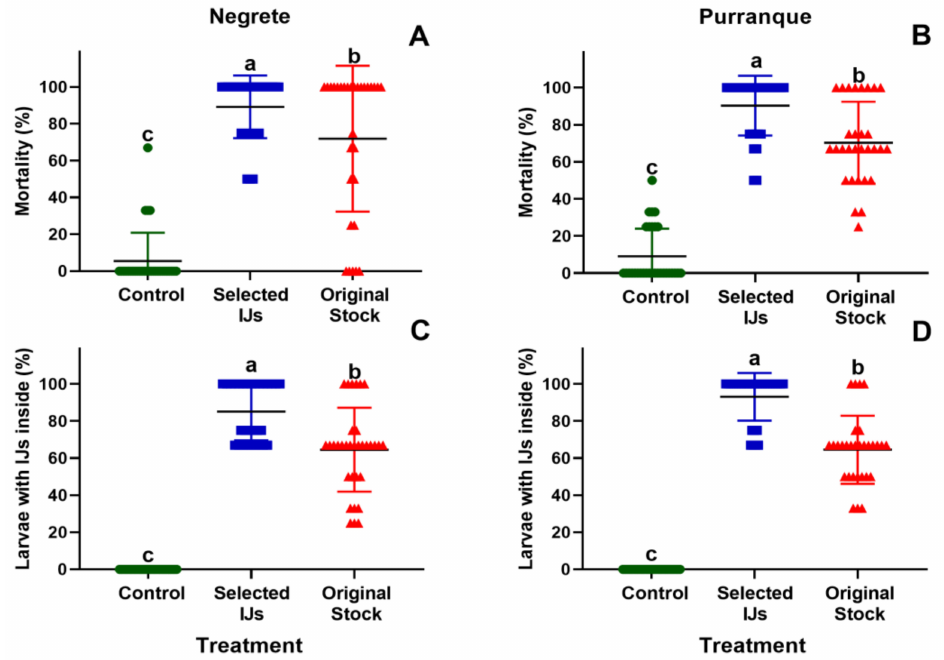
Figure 6. Efficacy (mean ± SEM) of the selected S. australe IJs (blue), original stock S. australe IJ (red), and control without nematode (green) in blueberry and sarsaparilla orchards, measured as a percentage of larval mortality ( A , B ); the percentage of larvae with a confirmed infection by EPN ( C , D ). Different letters indicate significant differences according to the Tukey HSD test ( p ≤ 0.05). With respect to the number of IJs that penetrated the larva, we found that 85% and with the selected IJs in blueberry and sarsaparilla, respectively. An average of 64% of larvae in larvae from the